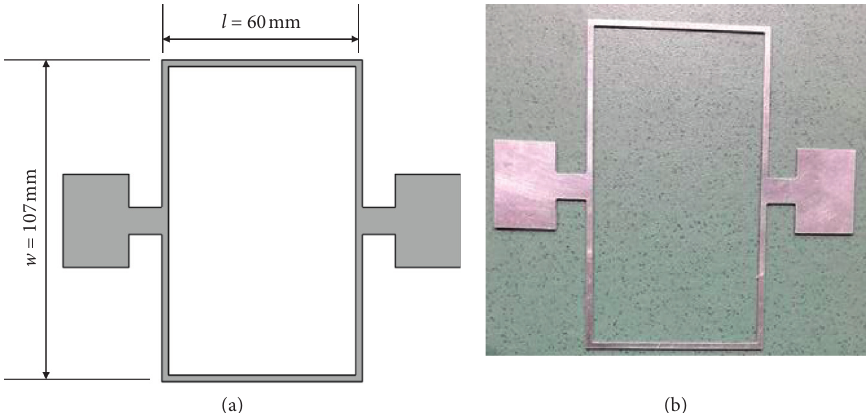
Figure 8: A traditional LET: (a) CAD model; (b) physical model.